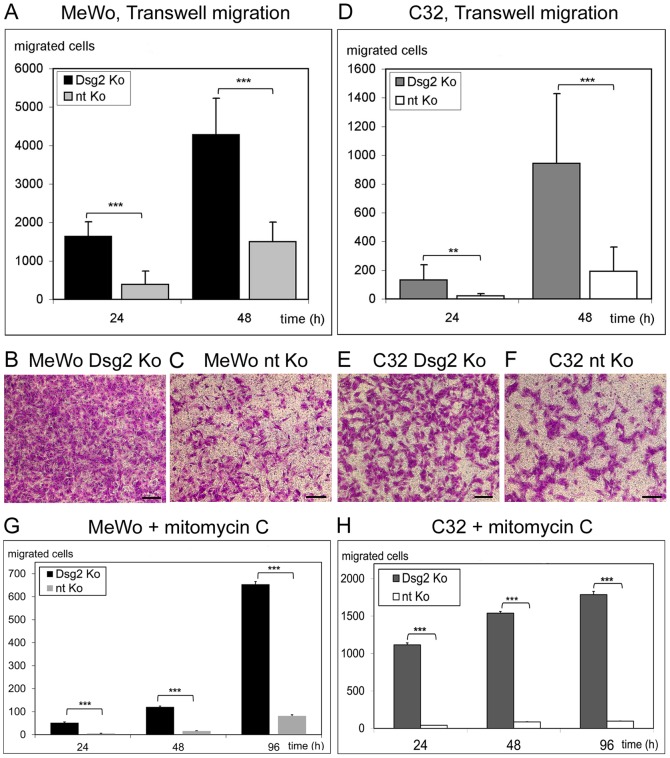
Depletion of Dsg2 leads to enhanced migration of melanoma cells.(A-F) Transwell migration assays comparing Dsg2-depleted (“Dsg2 Ko”) and non-targeting siRNA-treated (“nt Ko”) MeWo and C32 cells 24 and 48 h after seeding. (A, D) At both time points and in both cell lines substantially more Dsg2-depleted cells than controls had migrated through the filter. (B, C, E, F) Micrographs of hematoxylin-eosin stained filter bottoms taken after 48 h. Bars: 300 µm. (G, H) Transwell migration assays of Dsg2-depleted and non-targeting siRNA-treated MeWo (G) and C32 (H) preincubated with mitomycin C. Bars: SD; * p≤0.05, ** p≤0.01, *** p≤0.001.